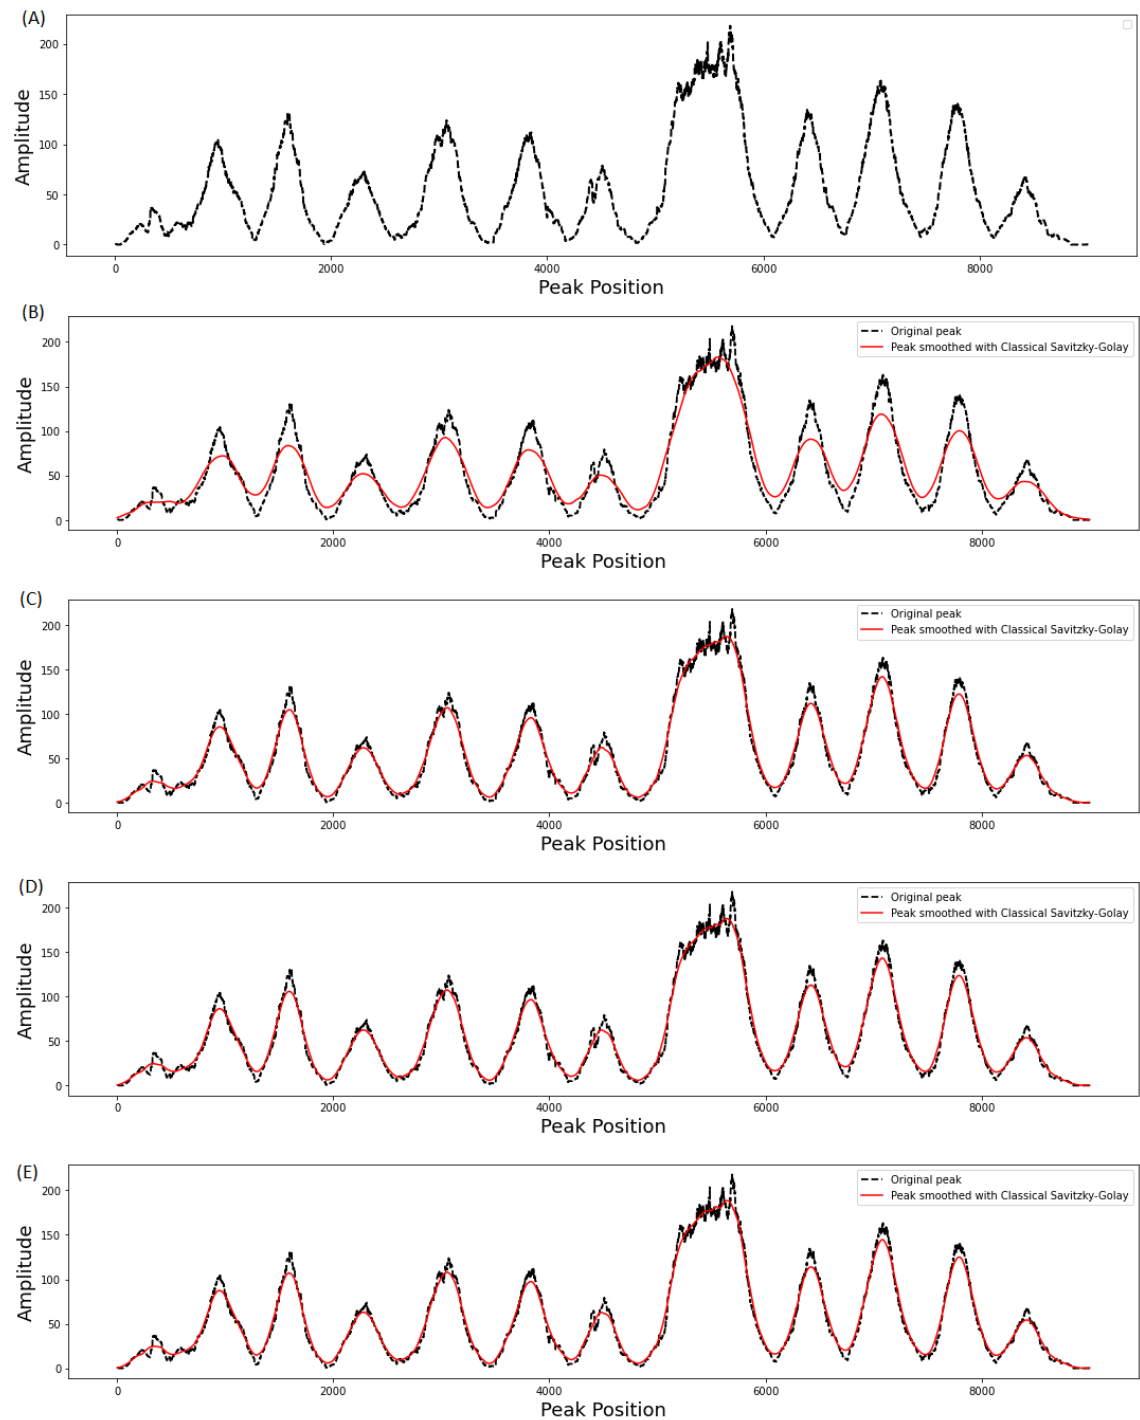
Figure 1. Smoothing performance of Classical Savitzky–Golay. ( A ): Original peak corrupted with noise; ( B ): SG filter k 1 = 2, m 1 = 253. ( C ): SG filter k 2 = 3, m 2 = 201. ( D ): SG filter k 3 = 4, m 3 = 153. ( E ): SG filter k 4 = 5, m 4 = 51. The dotted black line is the original peak and solid red line is the smoothed